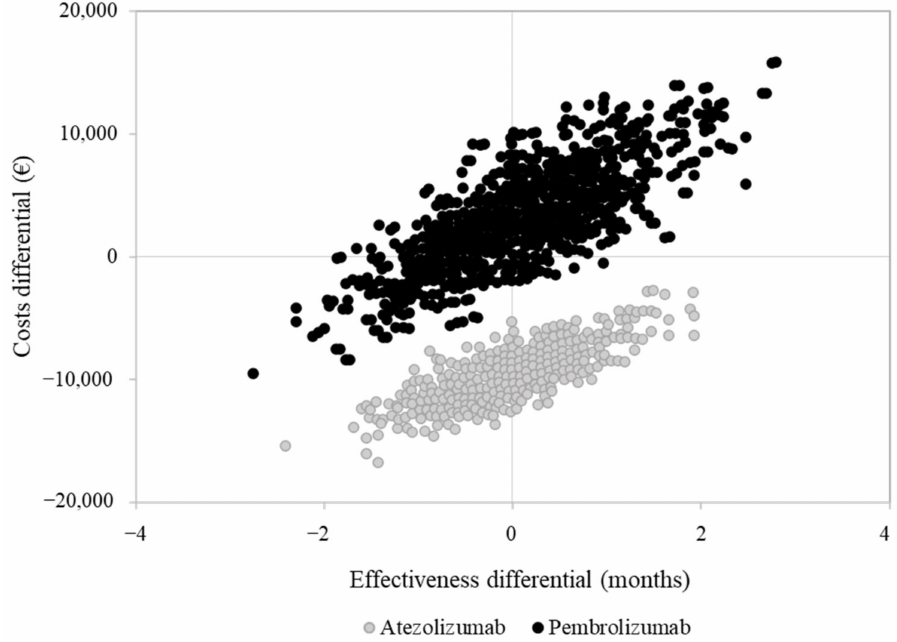
Figure 4. Cost-effectiveness analysis comparing second-line pembrolizumab and atezolizumab compared to